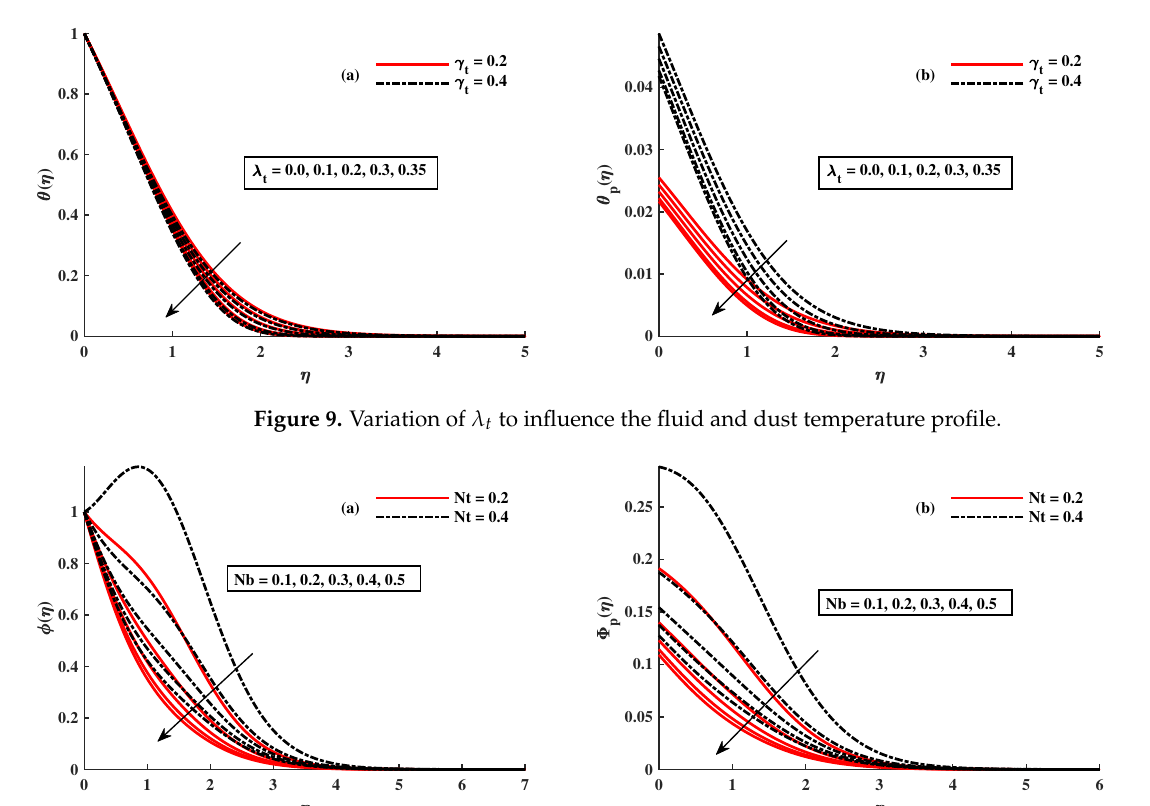
Figure 8. Variation of Nb to influence the fluid and dust temperature profile.